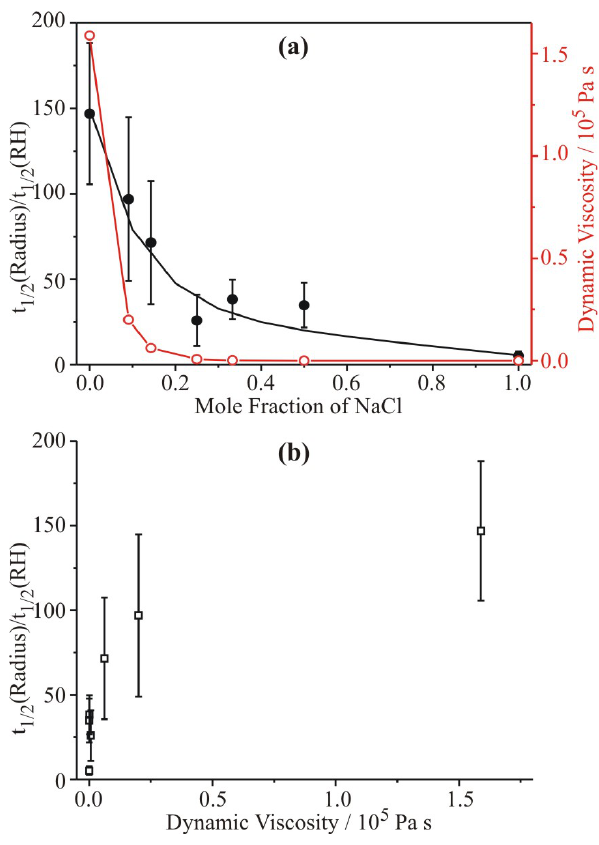
Fig. 9. (a) The composition dependence of the ratio of the half- times for the radius to the RH changes (black circles) for aqueous sodium chloride/sucrose droplets. The composition dependence of the dynamic viscosity at a solution composition with water activity of 0.4 is also shown (red circles, right axis). (b) Dependence of the half-time ratio shown in (a) on solution